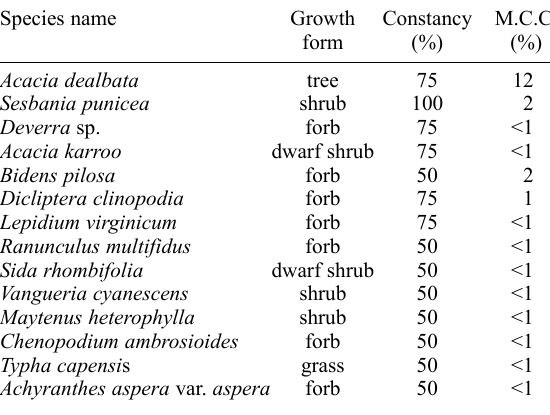
Table 9 Diagnostic species of the Acacia dealbata-Eragrostis curvula variant (M.C.C. - mean canopy